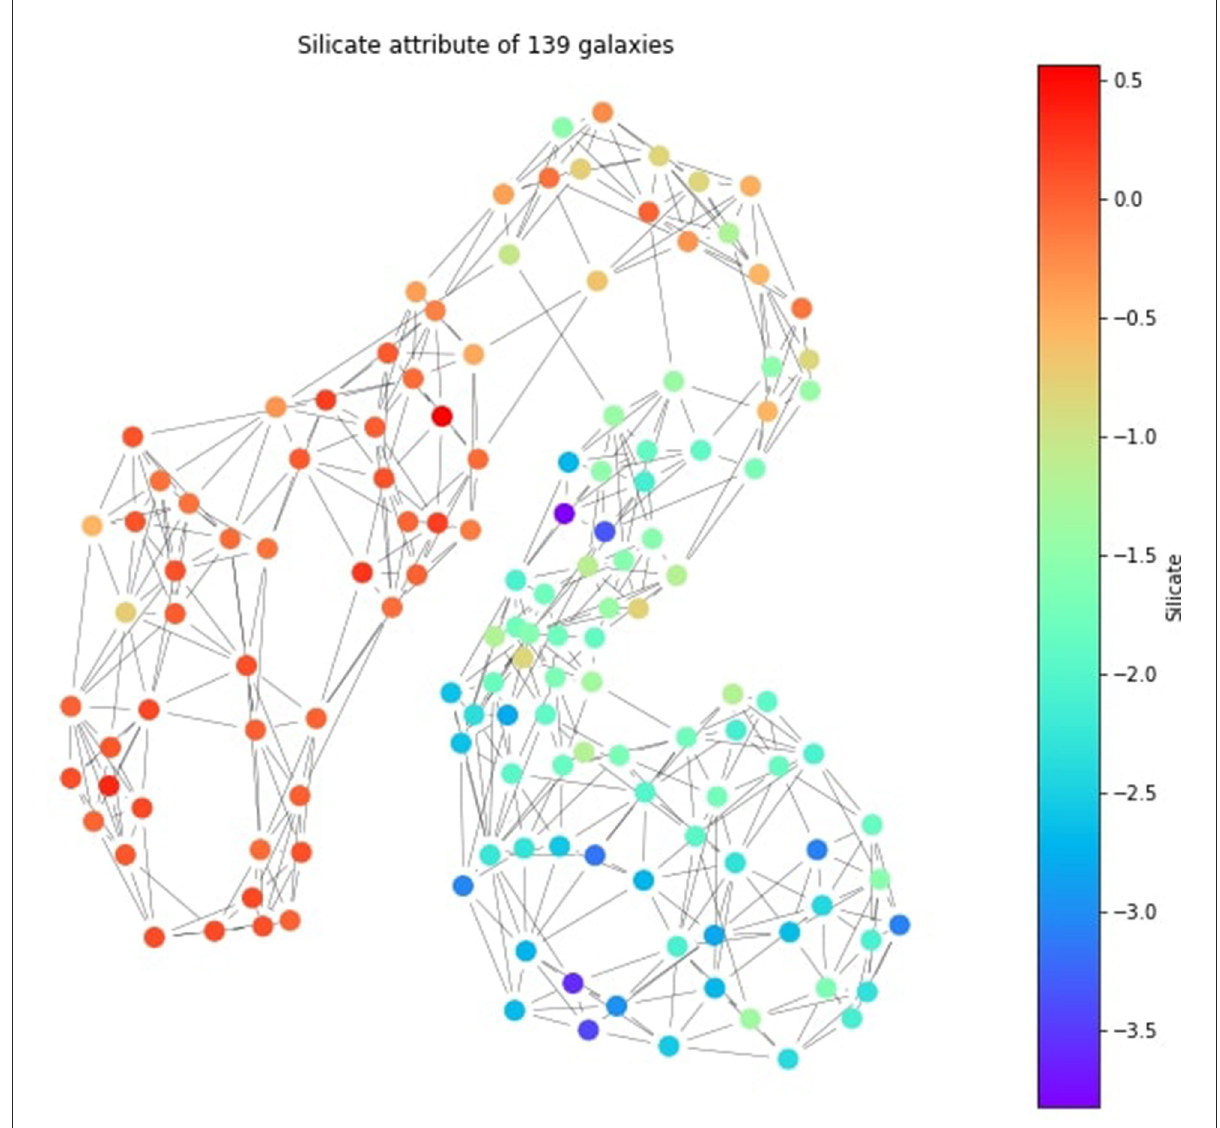
FIGURE13 The Silicate absorption/emission feature distribution on the graph. The transition from weak to strong silicate between PG quasars (orange-cyan clusters) and starburst galaxies (green-yellow clusters) is clearly observable.